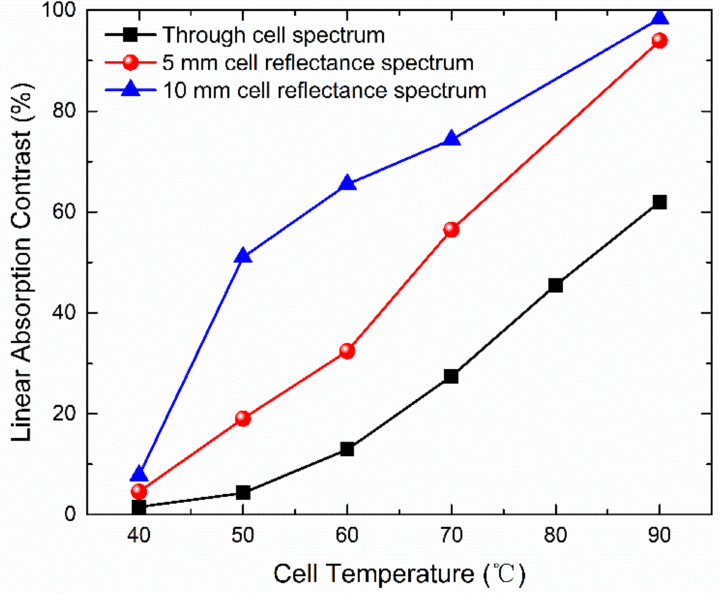
Figure 10. Linear absorption contrast comparison of vapor cells with different optical lengths at different